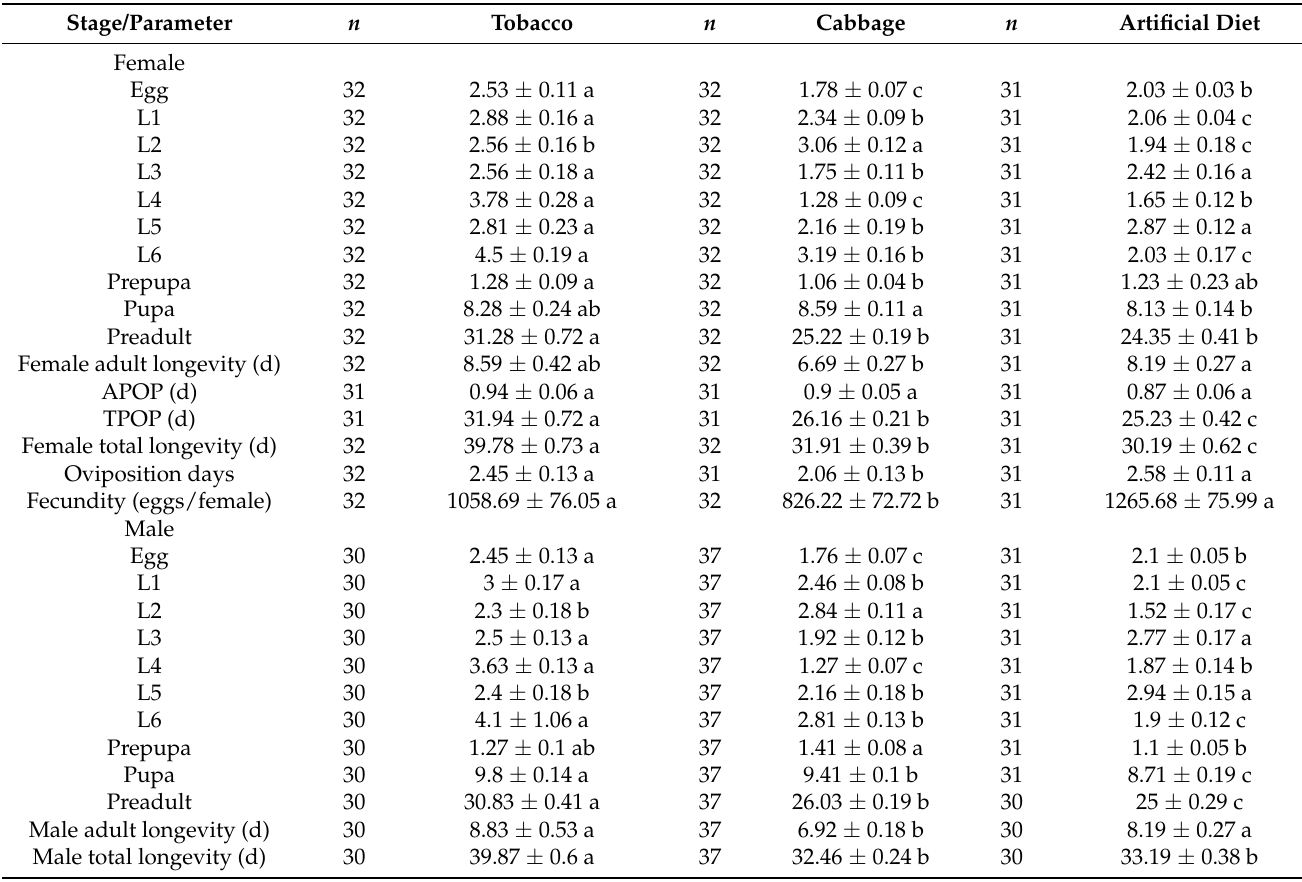
Table 1. Mean duration of life stages and fecundity of Spodoptera litura fed different diets.